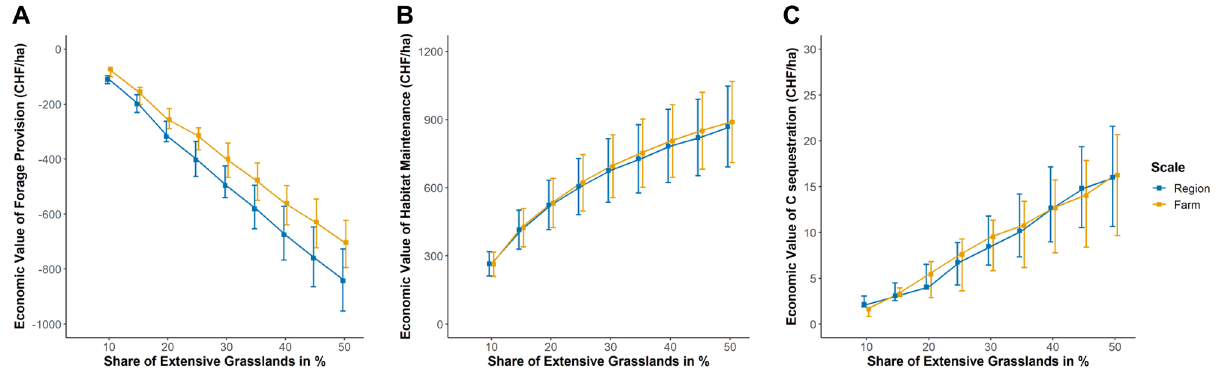
Figure 3. Economic value of forage provision, habitat maintenance and carbon sequestration from increasing the share of extensively managed grassland on farm and regional scale. Squares represent the change in mean values compared to intensive land use resulting from the random spatial allocation (500 simulation runs) for two spatial policy target levels q (region, farm). Error bars reflect minimum and maximum values reflecting price and willingness to pay variability in ecosystem service values from variation in price assumptions: ( A ) Economic value of forage production with forage price variability. ( B ) Economic value of habitat maintenance using willingness to pay estimates. ( C ) Economic value of carbon sequestration with carbon price